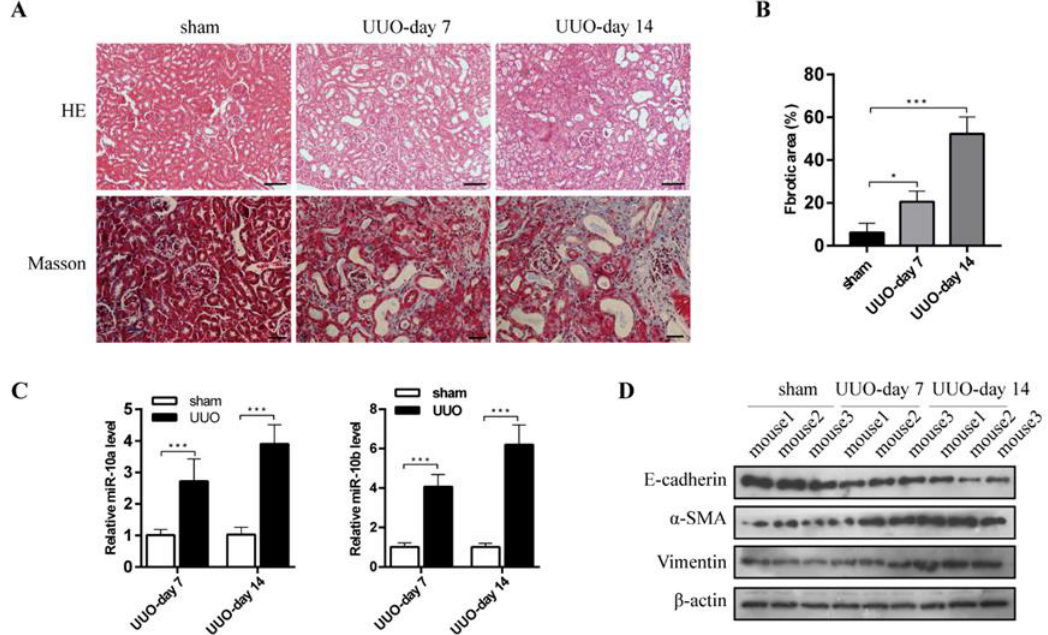
Figure 1. The expression of miR-10a and miR-10b were upregulated in UUO-induced mice kidneys. ( A ) Representative images of HE (image scale bars, 50 µ m) and Masson staining (image scale bars, 20 µ m) in kidney sections from UUO-induced WT mice for 7 and 14 days. Sham group was used as a control. ( B ) Quantitative analysis of the blue staining area of fibrosis. The sham group was used as a control. ( C ) RT-qPCR analysis for miR-10a and miR-10b in mouse kidneys with/without UUO- induced RF. ( D ) Western blot for E-cadherin, α -SMA, and vimentin in mouse kidneys with/without UUO-induced RF. * p < 0.05, *** p < 0.001.